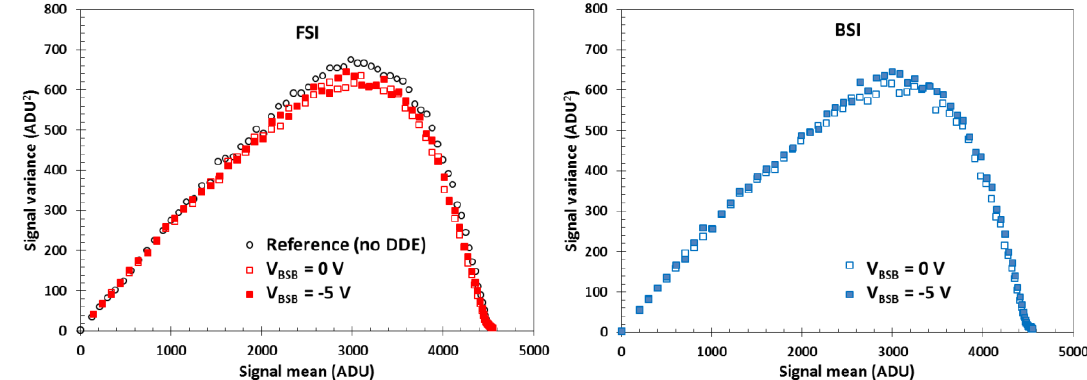
Figure 10. Photon transfer curves (PTCs) (“mean-variance” type with frame differencing) of a 10 µm pixel variant #1 in FSI and BSI implementation with high V pin and medium DDE. One ADU is 305 µV.